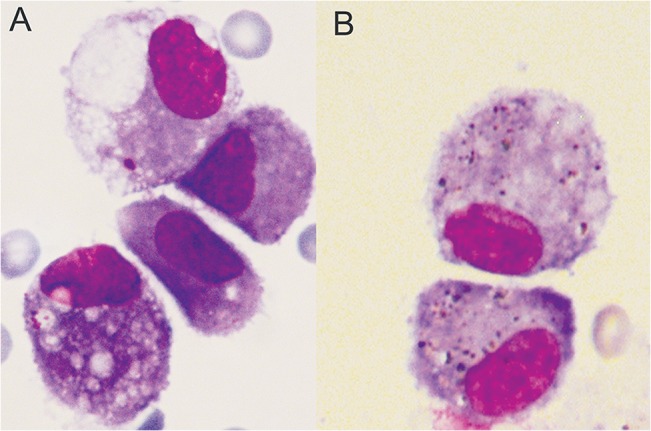
Light microscopic analysis.Images of BALF macrophages 24 hours after administration of A) 16 μg/mouse functionalised ZnO and B) 8 μg/mouse Ag.